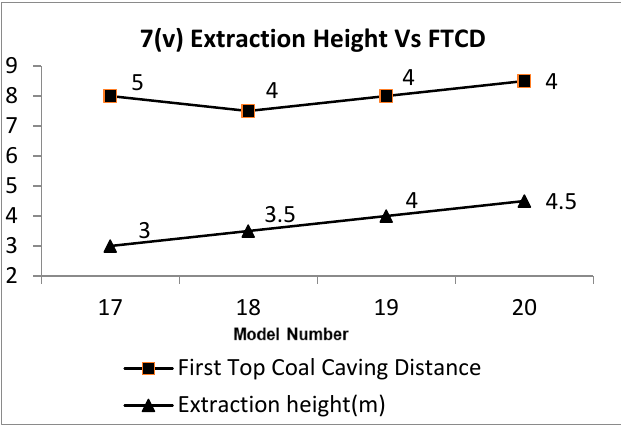
Figure 7. Graphs showing influence of various parameters on FTCD: 7( i ) uniaxial compressive strength vs FTCD; 7( ii ) RMR vs FTCD; 7( iii ) cover depth vs FTCD 7( iv ) top coal thickness vs FTCD, and 7( v ) extraction height vs FCTD.